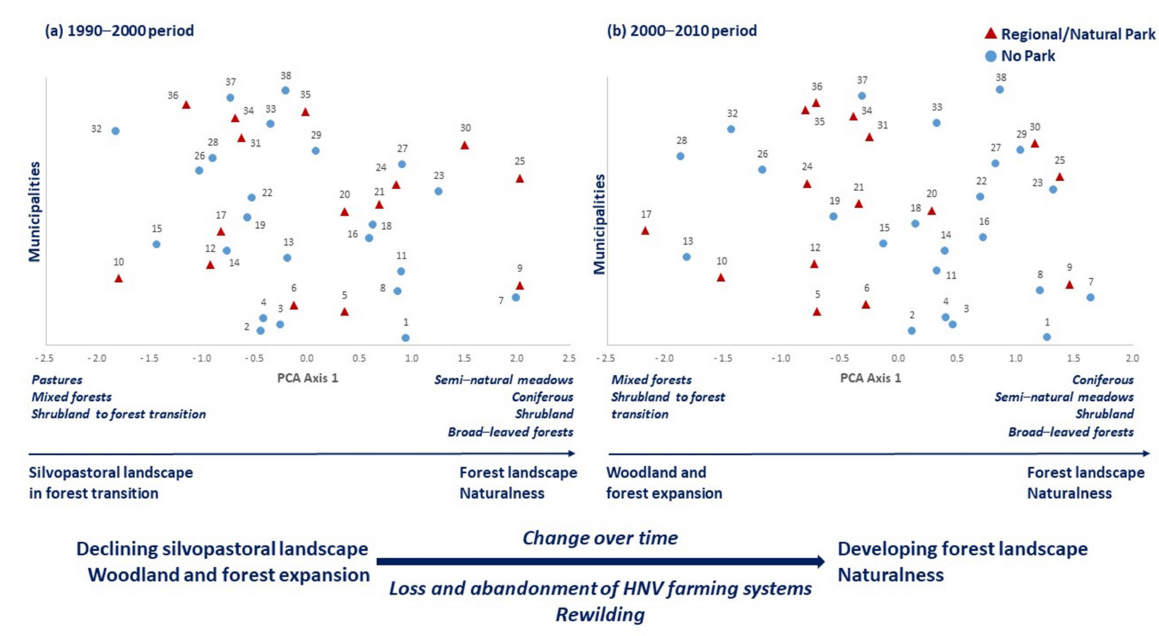
Figure 3. Land use dynamics. Coordinates of the municipalities of the study area along PCAs-axes 1: ( a ) period 1990–2000; ( b ) period 2000–2010. Land use indicators (variables with higher loadings in the PCAs) are shown at both ends of the axes (see Table 2). The codes of the municipalities are indicated in Appendix